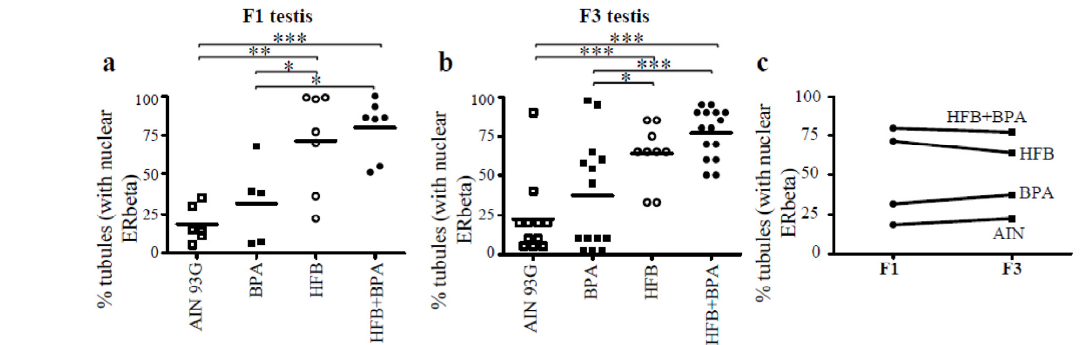
Figure 5. Cytoplasmic and nuclear expression of ERbeta in round spermatids (T + E2 − treated). ( A ) Testis of F3-generation offspring were scored for number of STs with ERbeta staining in cytoplasm of round spermatids. Each symbol represents a pup from an independent litter. ( B ) Comparison of STs with ERbeta staining in nucleus of round spermatids within each group (AIN, BPA, HFB, and HFB + BPA) in ( a ) F1 and ( b ) F3 generation offspring. ( c ) Comparison of F1 and F3 nuclear ERbeta expressing tubules. * p < 0.05, ** p < 0.01, *** p < 0.001 using one-way ANOVA between groups indicated, followed by Dunnett’s multiple comparison test. Two sections examined per